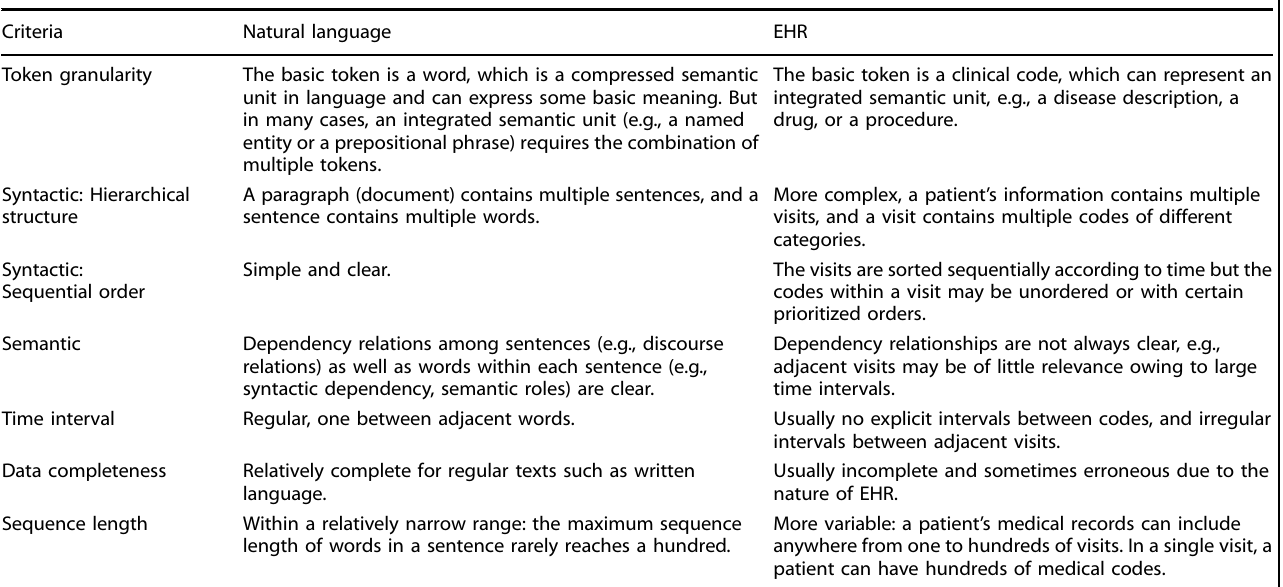
Fig. 2 An example of structured EHR data of a hypothetical patient as it would be available from a typical EHR system (e.g., Cerner or Truven). For this patient, four visits with dates and encounter types are organized according to chronological order at the bottom. Detailed information including demographic and medical codes with time stamps are shown above. Note that not all information is recorded, as in real-world EHR recording Table 3. Comparison of characteristics of EHR data versus Natural language data.